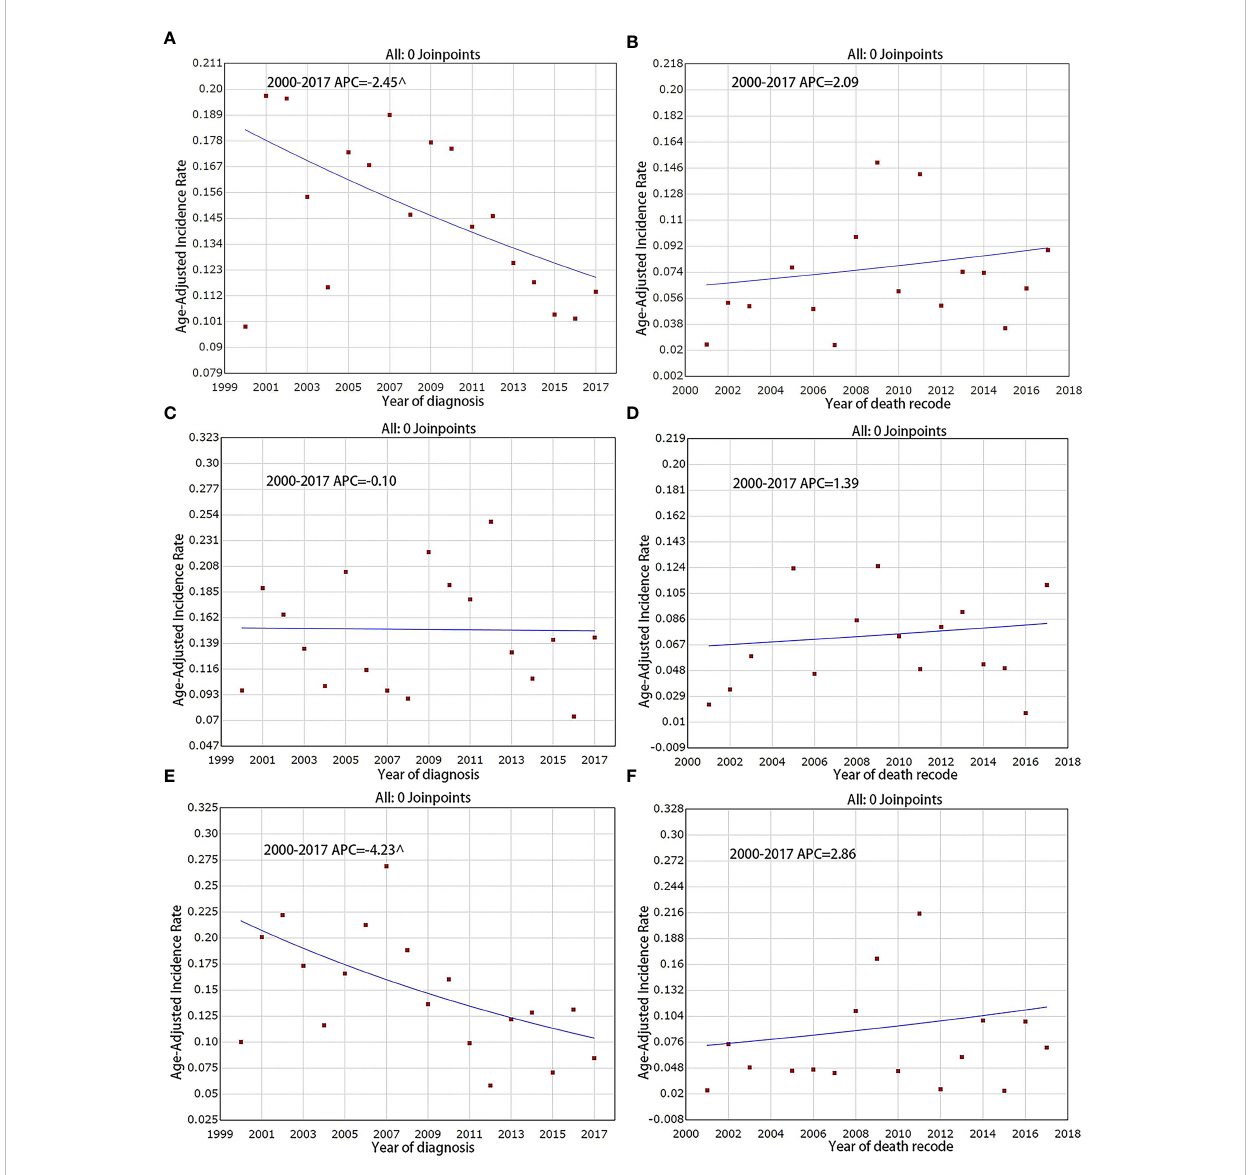
FIGURE 2 Incidence and IB mortality trends of F-PNETs overall and by sex, 2000 – 2017. (A) Incidence trends of F-PNETs. (B) IB mortality trends of F-PNETs. (C) Incidence trends of Male. (D) IB mortality trends of Male. (E) Incidence trends of Female. (F) IB mortality trends of Female. ^ mean that P < 0.